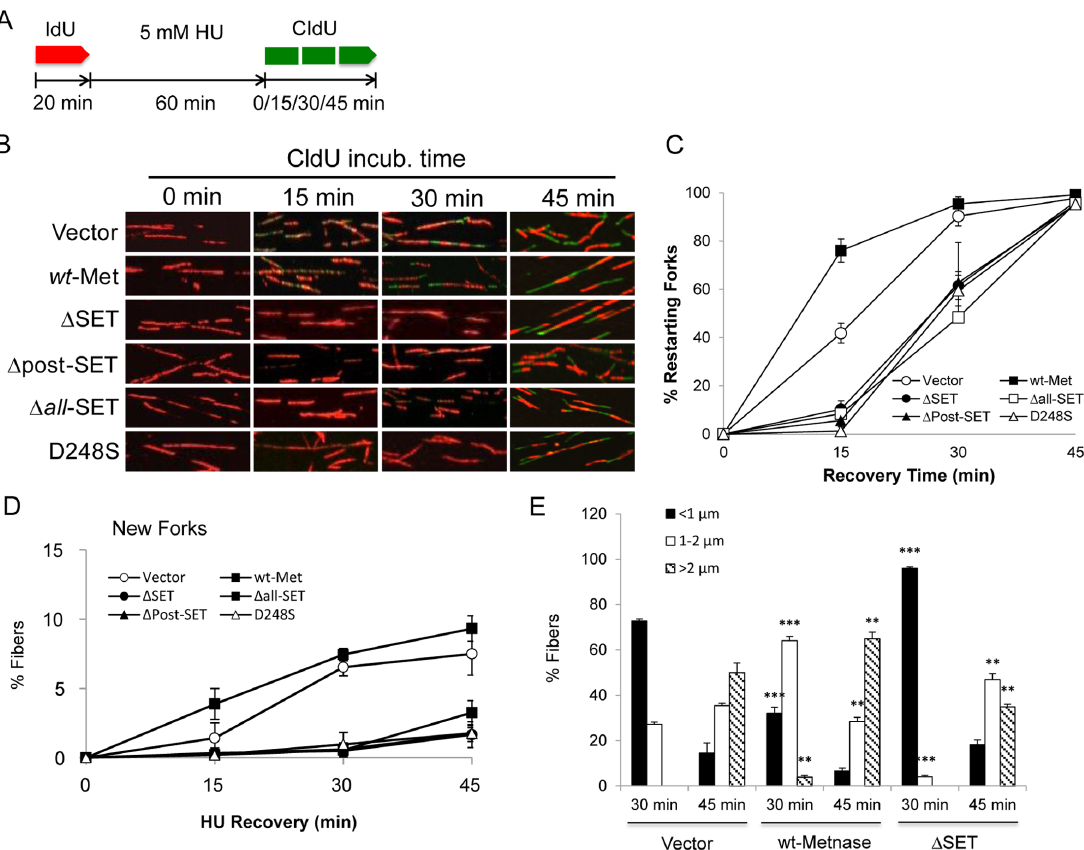
Fig 3. The Metnase SET domain has a crucial role in replication fork restart following HU treatment. (A) Dual labeling protocol for replication restart using DNA fiber analysis. Cells were pulse-labeled with IdU (red) for 20 min, treated with 5 mM HU for 60 min, and labeled with CldU (green) for 0, 15, 30, and 45 min. (B) Representative confocal microscope images of replication tracks from HEK293 cells stably expressing vector (top row), wt-Metnase (2 nd row), and the SET deletion/substitution mutants (3 rd - 6 th rows). Cells were treated with 5 mM HU prior to pulse labeling with CldU for indicated amounts of time. (C-D) Average percentage ( ± SD) of restarted forks (red plus green; panel C) and new forks (green only; panel D) for three independent experiments in which 150 – 200 fibers were scored per each determination. (E) Fiber lengths were measured by using Olympus FV1 — ASW 3.0 software. Average lengths of 150 – 200 fibers were scored in triplicates per each determination. ** , P < 0.01; *** , P < 0.005 (compared with vector control), t tests.